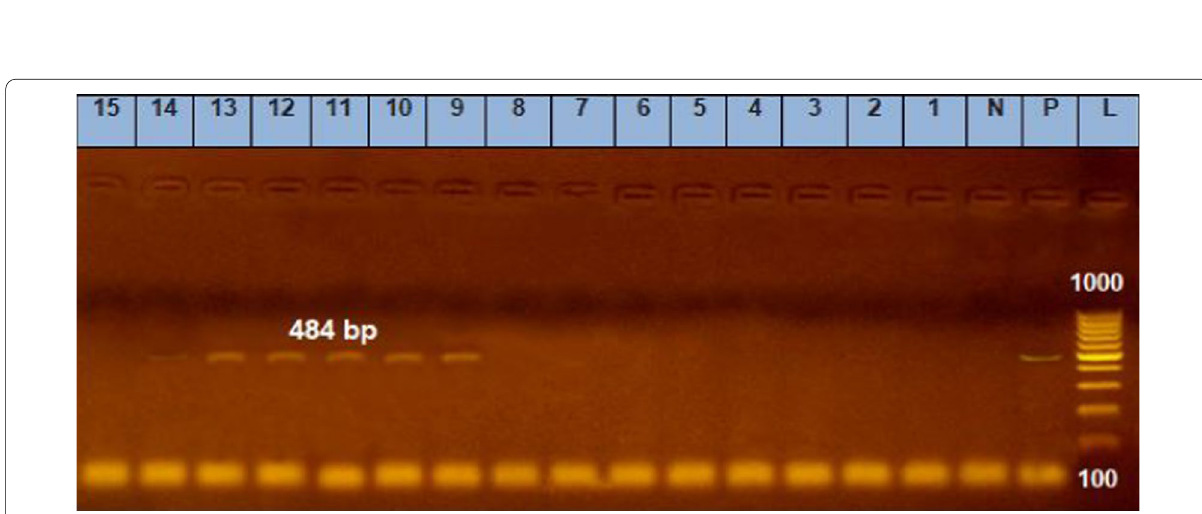
Fig. 12 Agarose gel electrophoresis showing amplification product of 484 bp of AadA1 . Lane L : Ladder (Marker) 100‑1000 bp plus DNA ladder. Lane P : control positive. Lane N : control negative. Lane 1–15 : examined isolates